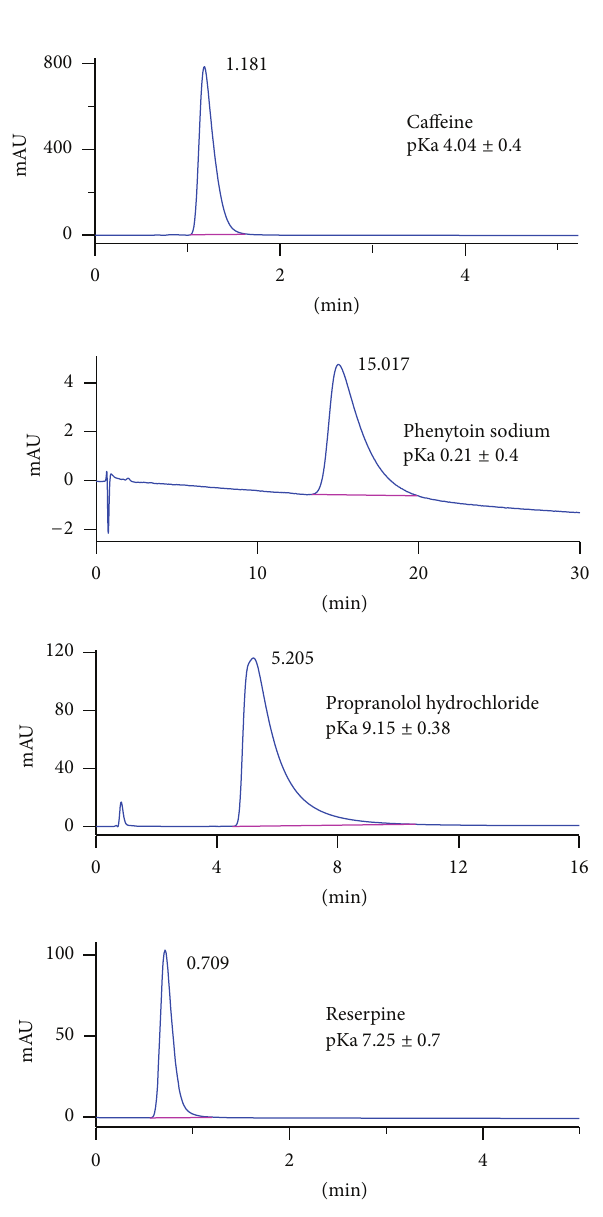
Figure 2: Representative chromatograms of some reference com- pounds analysed on HSA column.